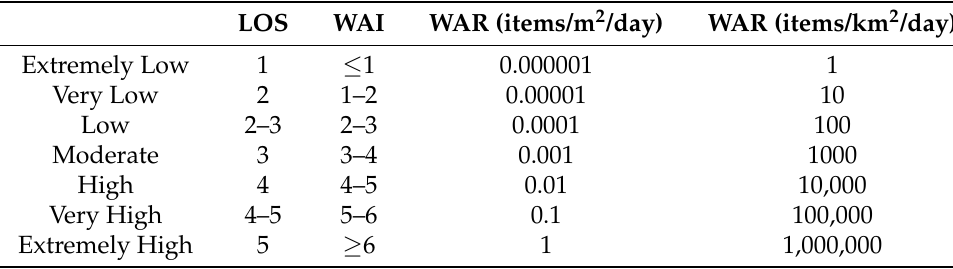
Table 7. Accumulation rate and index